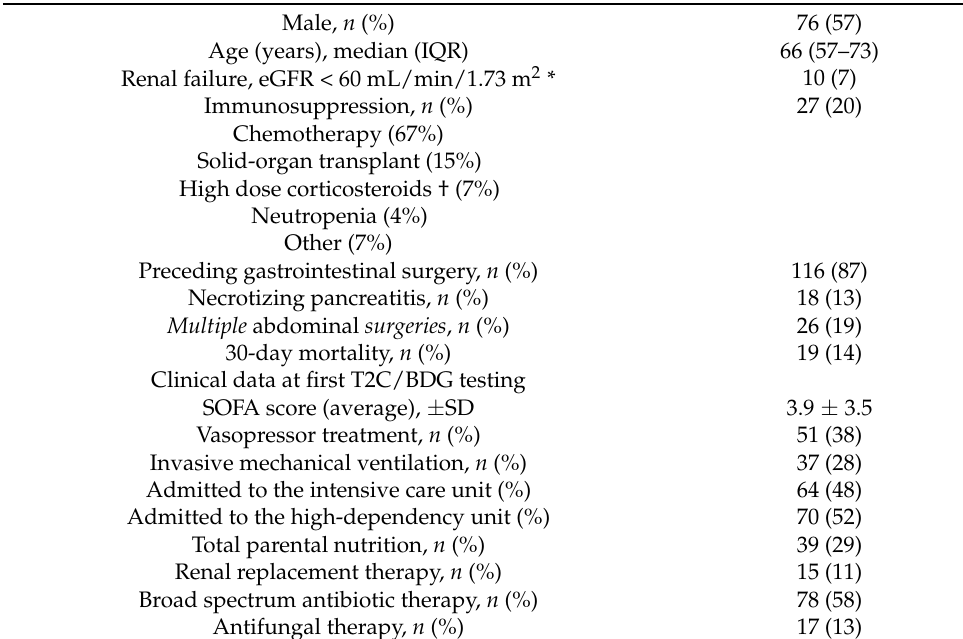
Table 3. Performances of T2C and BDG for IAC criteria, n = 134.